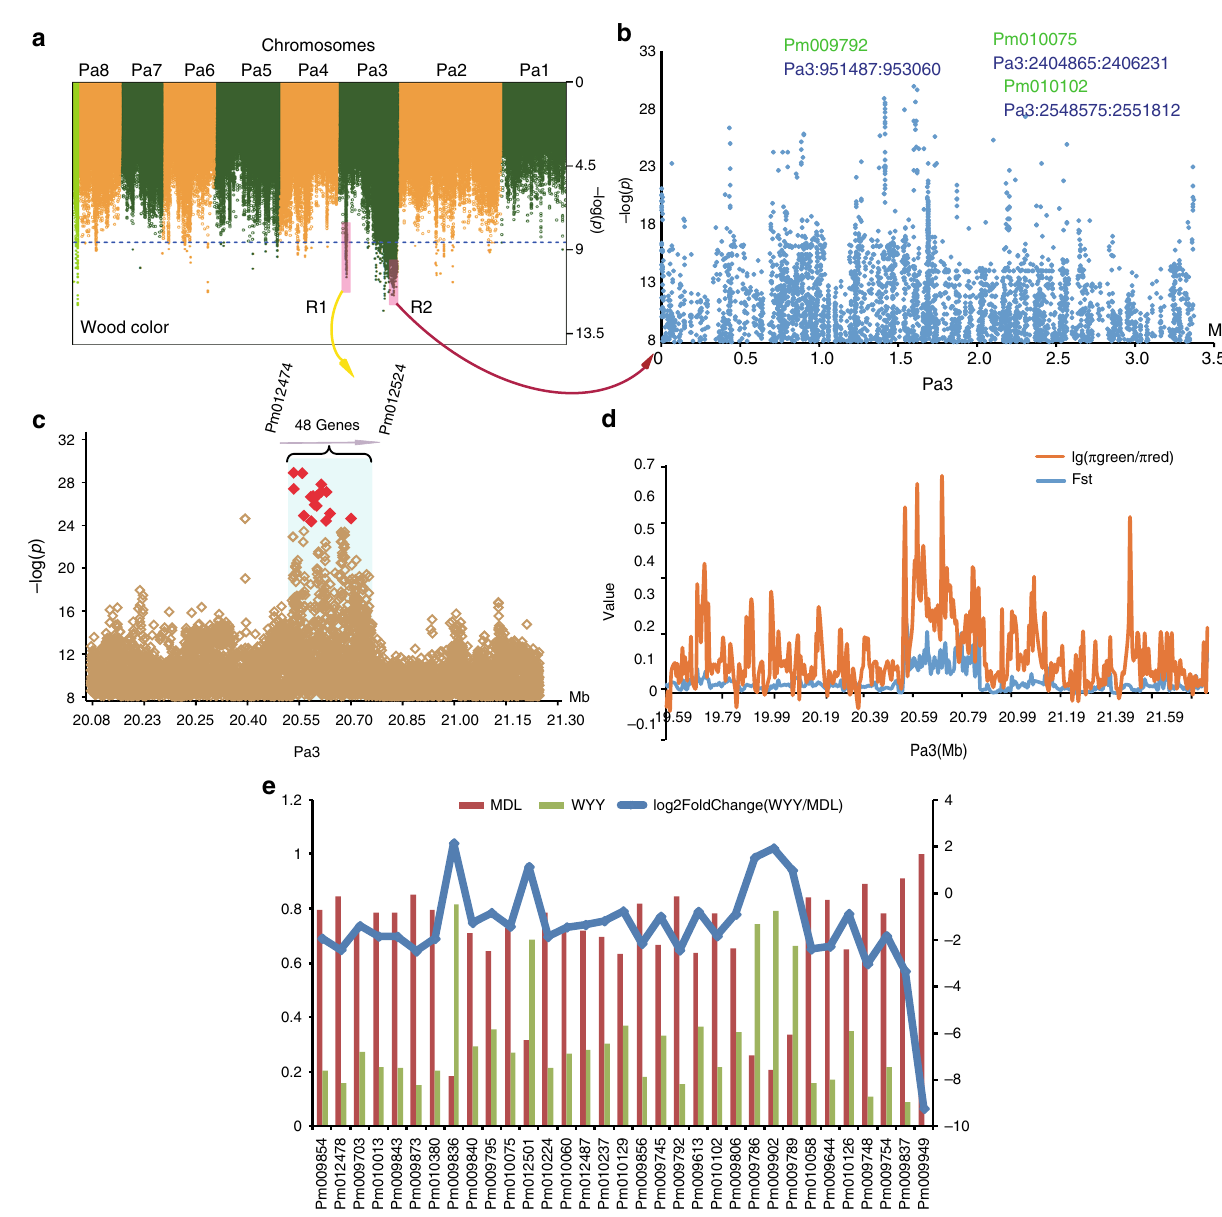
Fig. 5 GWAS results of wood and staminal fi lament color traits. a Manhattan plot of the wood color trait on the eight chromosomes of mei. b The region signi fi cantly associated with staminal fi lament color, designated as R2. c The region signi fi cantly associated with wood color, designated as R1, contained 48 candidate genes. d Comparative analysis of SNP polymorphisms between green wood and red wood groups. Values for π and Fst were calculated to identify possible selective sweep regions. e Comparison of the transcript expression of SEGs located in the R1 region signi fi cantly associated with wood color and staminal fi lament